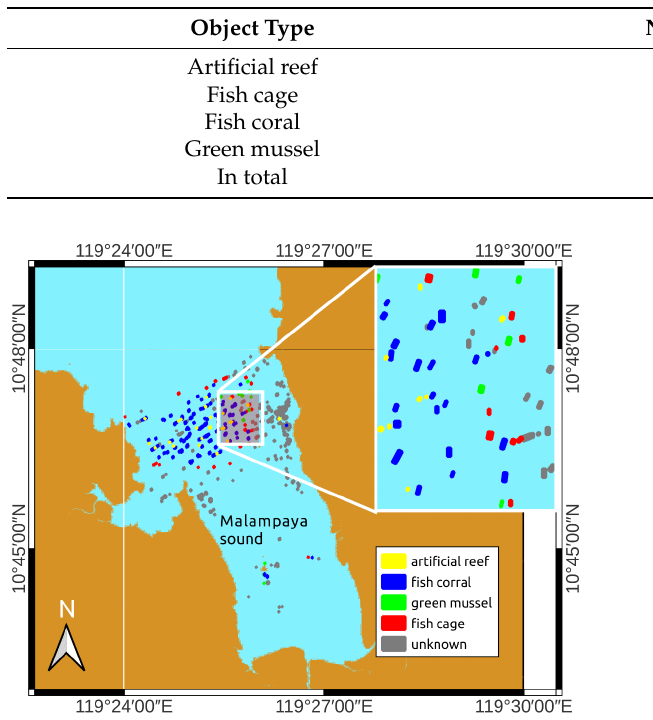
Figure 10. The classification of detected objects based on the Malampaya Sound survey: fish cages are shown in red, green mussels in green; fish corrals in blue; and artificial reefs in yellow. The unknown objects are shown in